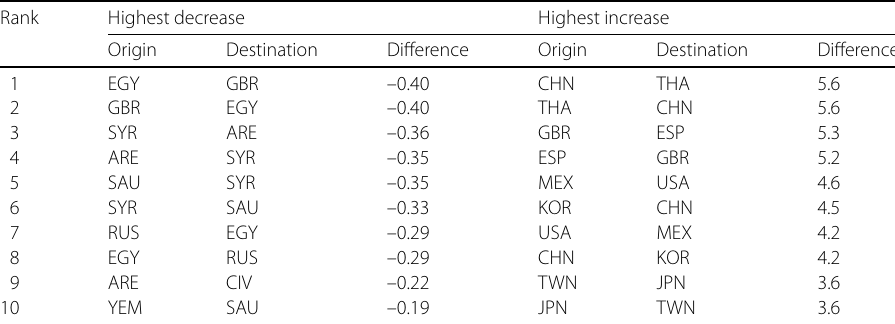
Table 1 The highest decreases and increases in mobility between 2011 and 2016 (in million